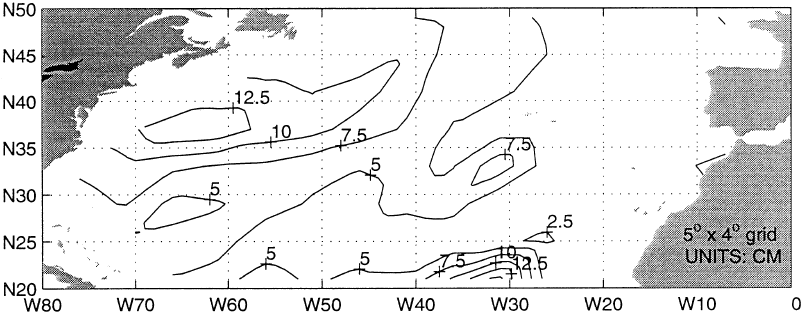
Fig. 5. Uncertainty (cm) in the 5 (cid:176) (cid:180) 4 (cid:176) mean dynamic topography estimate of